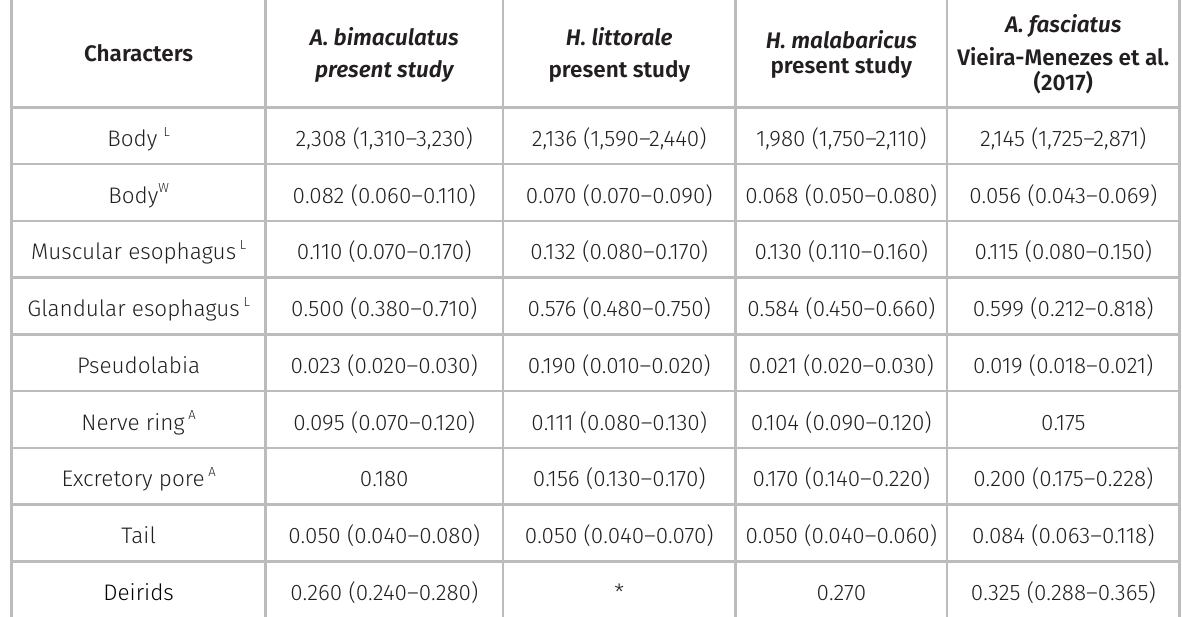
L = length; W = width; A = distance from the anterior end of body; * = structure not